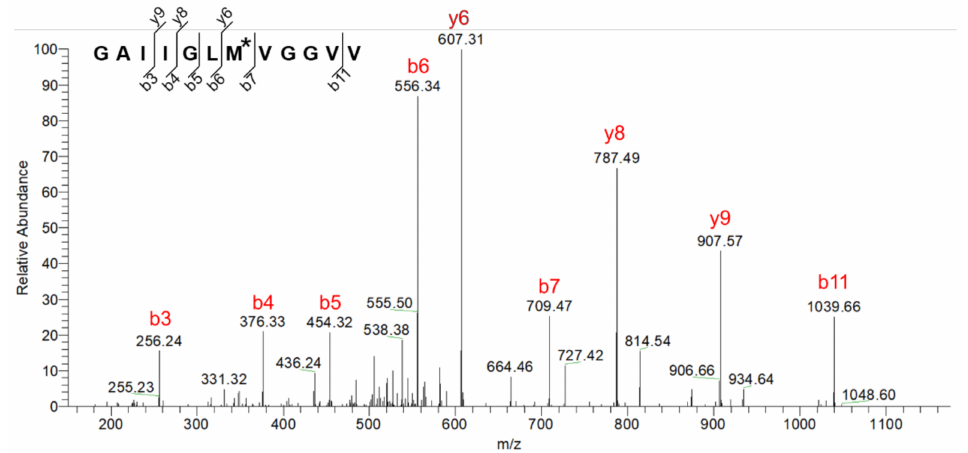
Figure 5. LC-MS/MS fragmentation profile of tryptic peptide of A β (1–40) fraction corresponding to peak-1. M* denotes oxidized